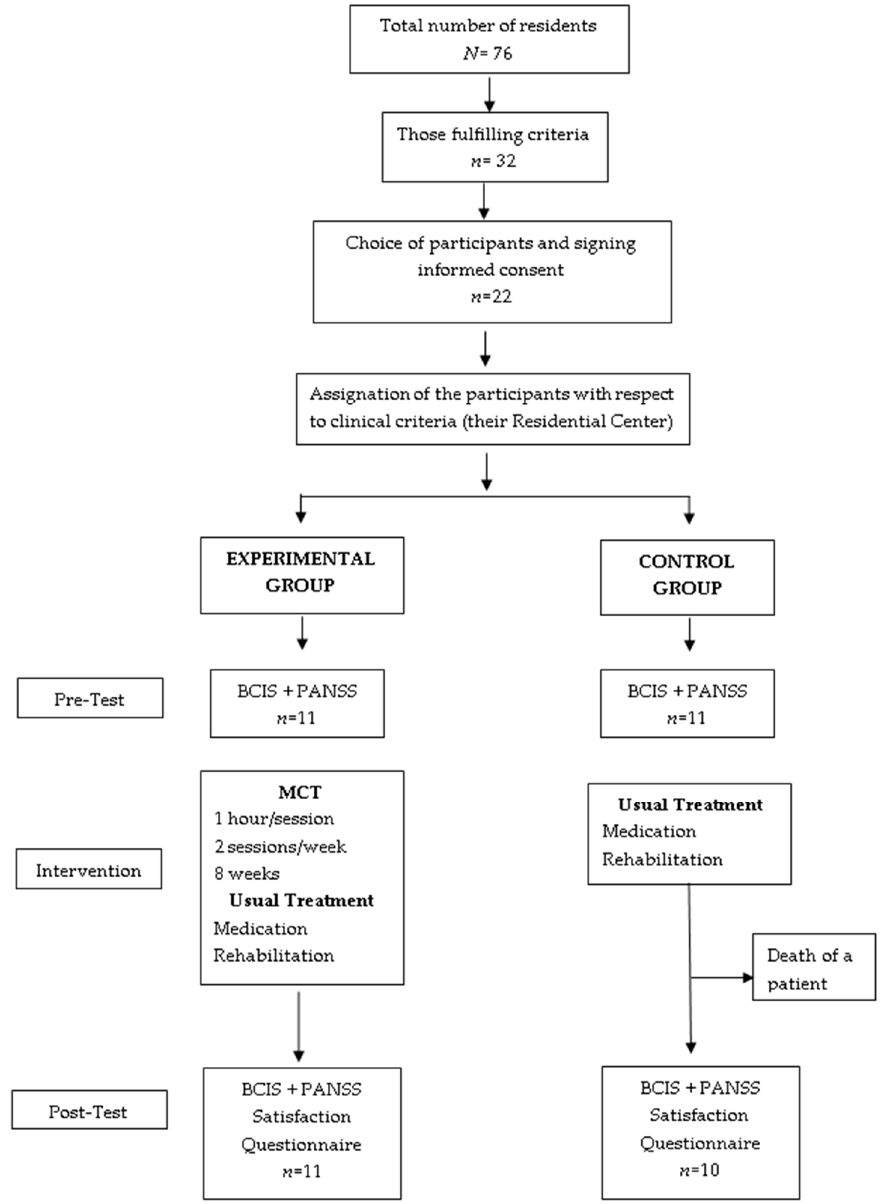
Figure 1. Progress of participants through the stages of the study. MCT: metacognitive training.